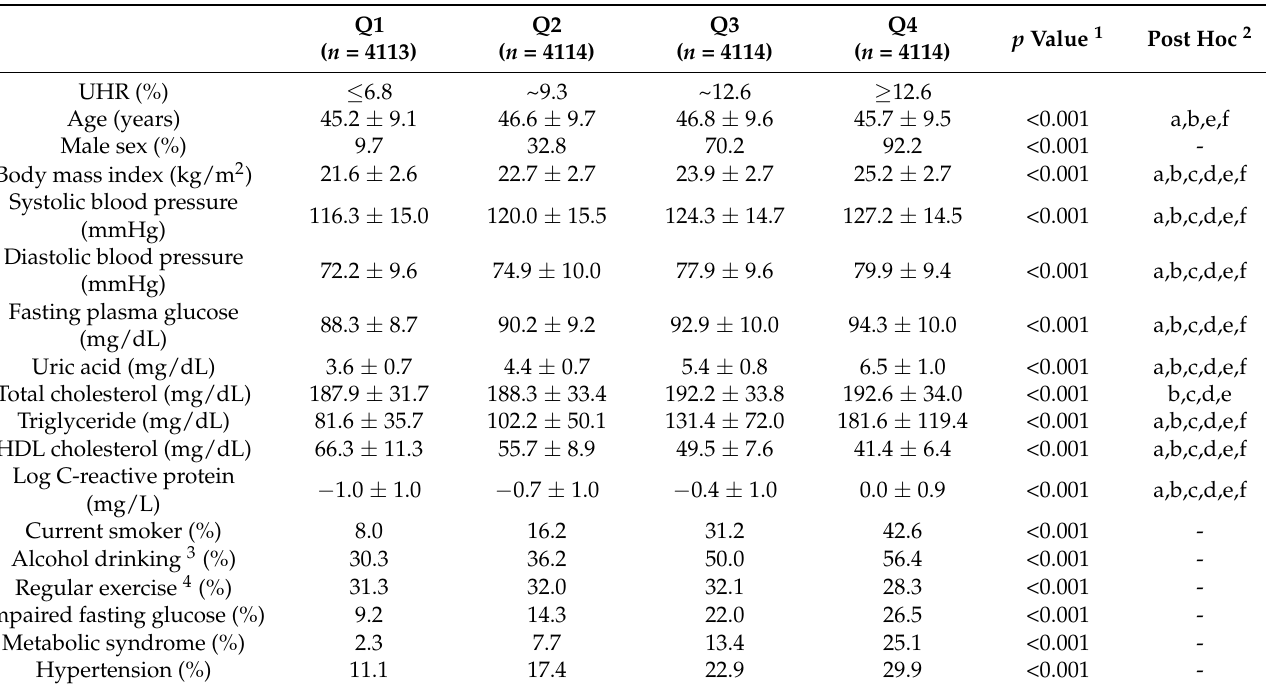
Table 1. Baseline characteristics of the study population.